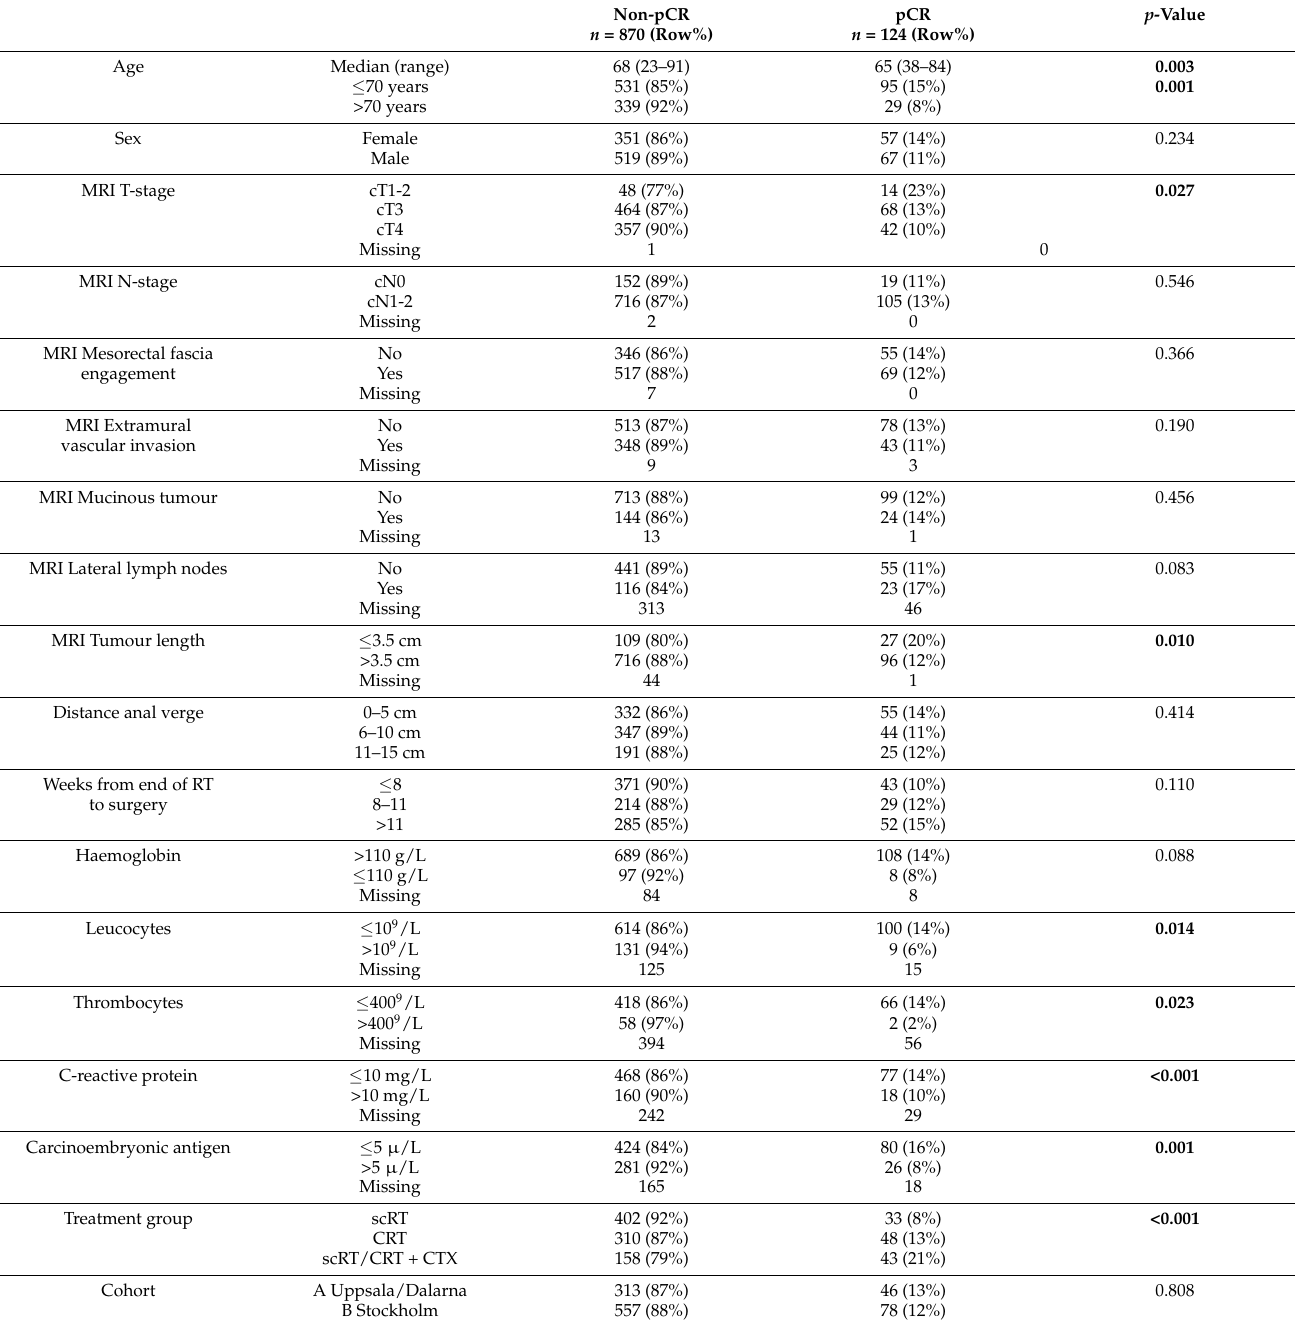
Table 2. Differences in baseline clinical, laboratory, and imaging-defined characteristics and treatment groups between the pCR and the non-pCR groups for the pooled cohort ( n = 994). Non-pCR pCR p -Value n = 870 (Row%) n = 124